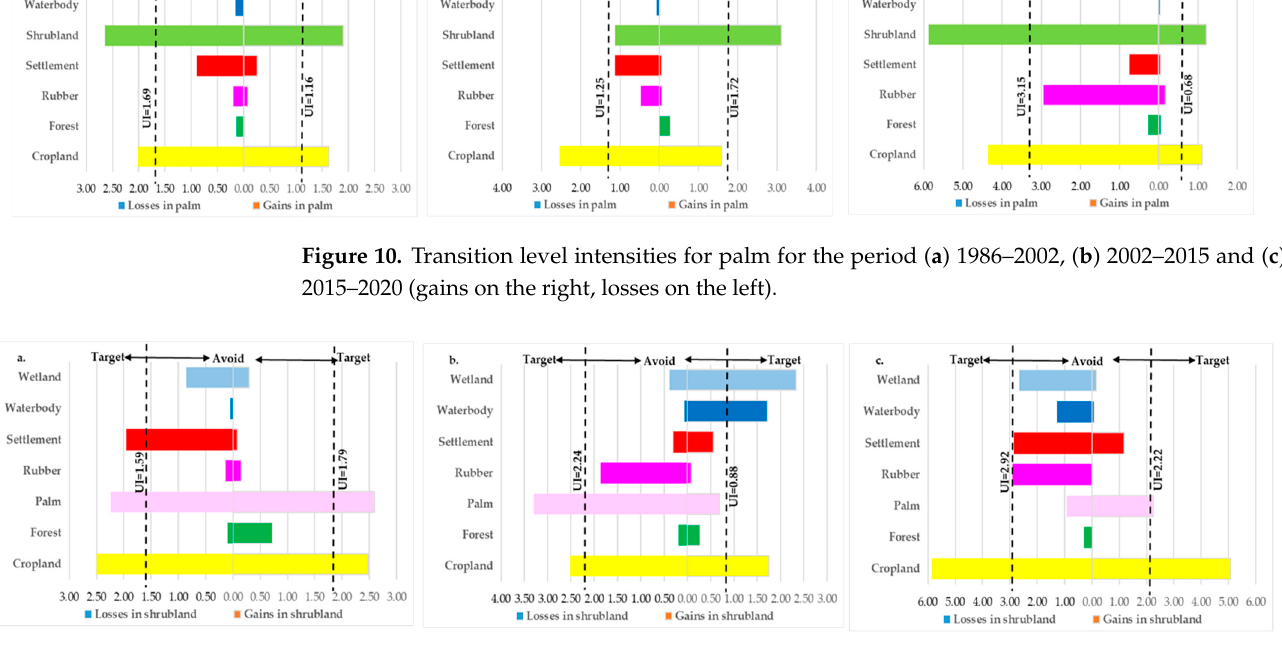
Figure 11. Transition level intensities for shrub land for the period ( a ) 1986–2002, ( b ) 2002–2015 and ( c ) 2015–2020 (gains on the right, losses on the left).